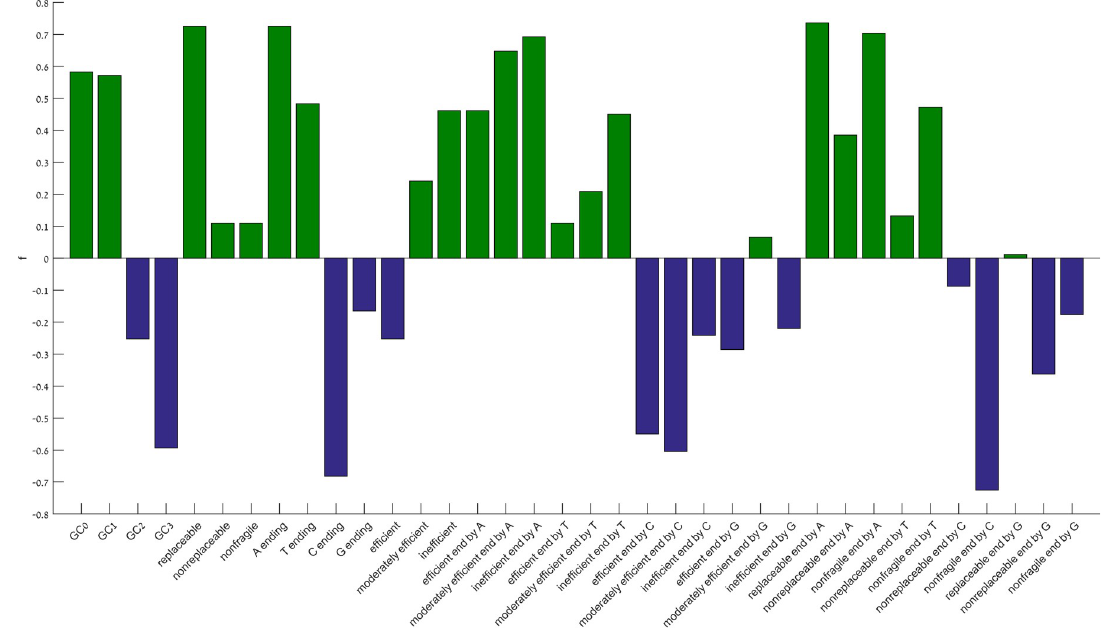
Fig 1. Preference of codon features towards the gene end. For each codon group we calculated the sum of scores (S5 Table) divided by the total number of species, f . Green bars mark features in which group RSCA significantly increase, blue bars mark features that are significantly decreased toward